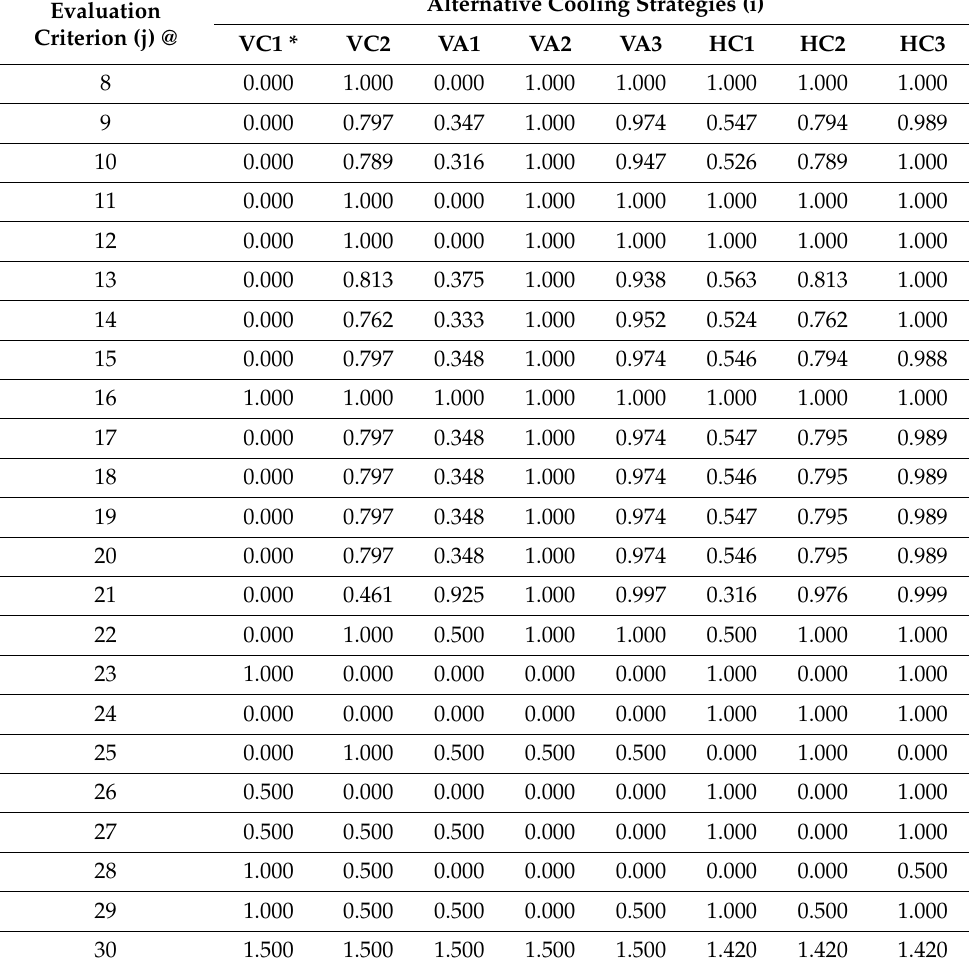
Table 9. Standardized Decision matrix S (cid:48)